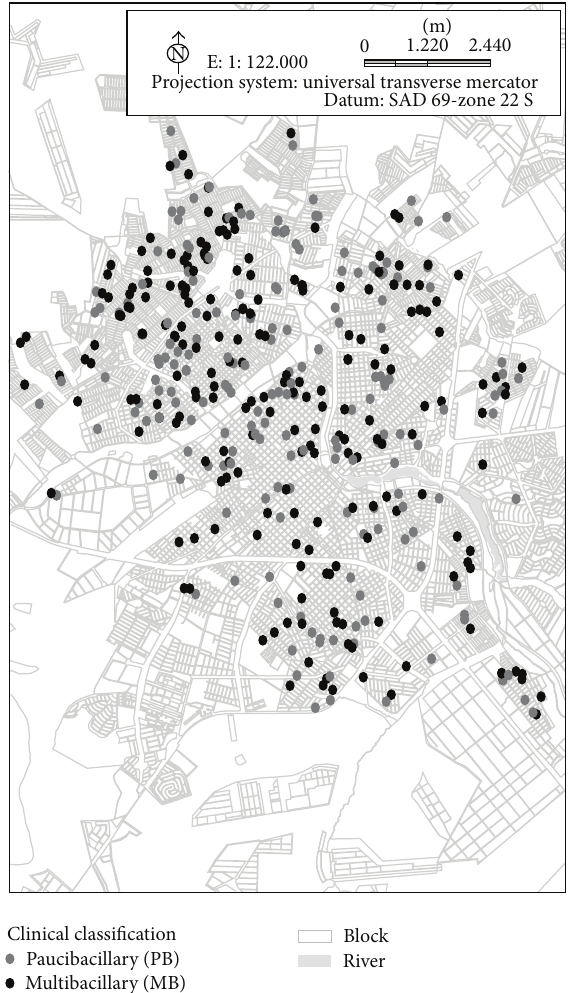
Figure 1: Spatial distribution of leprosy cases paucibacillary (PB) and multibacillary (MB) treated between 1998 and 2010 according to disease transmission